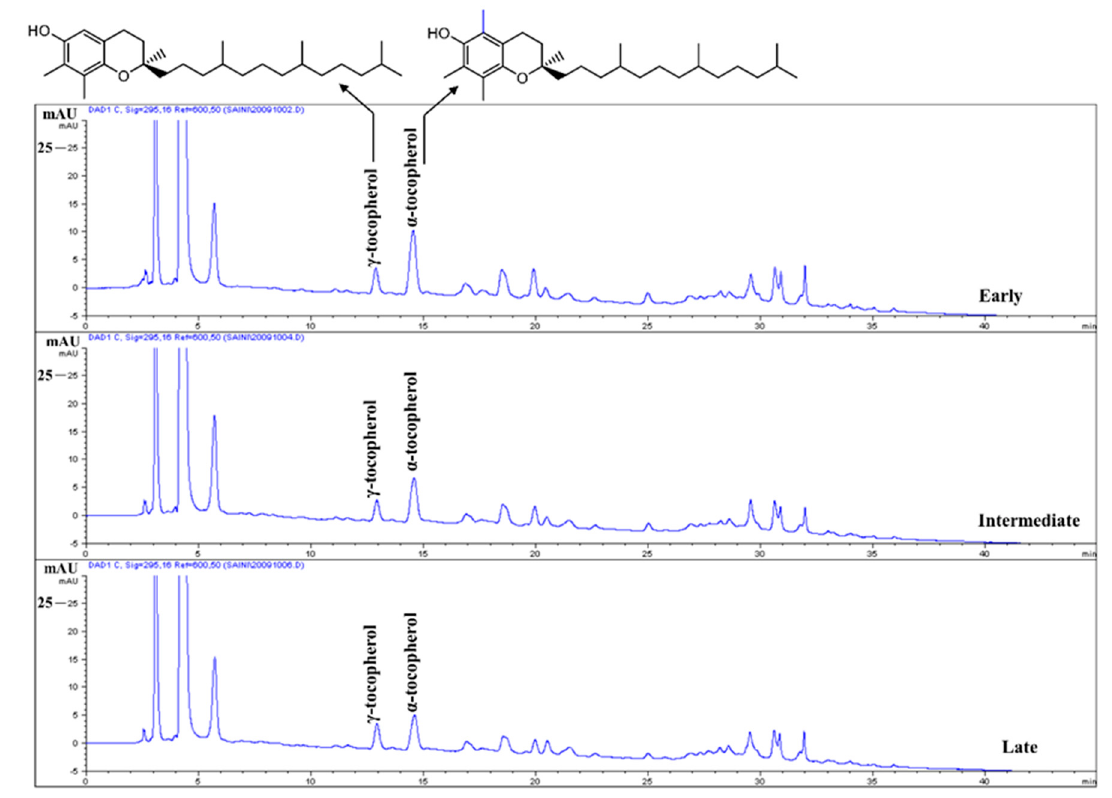
Figure 5. High-performance liquid chromatography (HPLC)-diode-array detection (DAD) chromatograms (295 nm) of γ -tocopherol (RT—12.925 min) and α -tocopherol (RT—14.587 min) from the egg yolks of eggs obtained from early, intermediate, and late-age laying hens. All the chromatograms are on the same scale. RT: retention time.